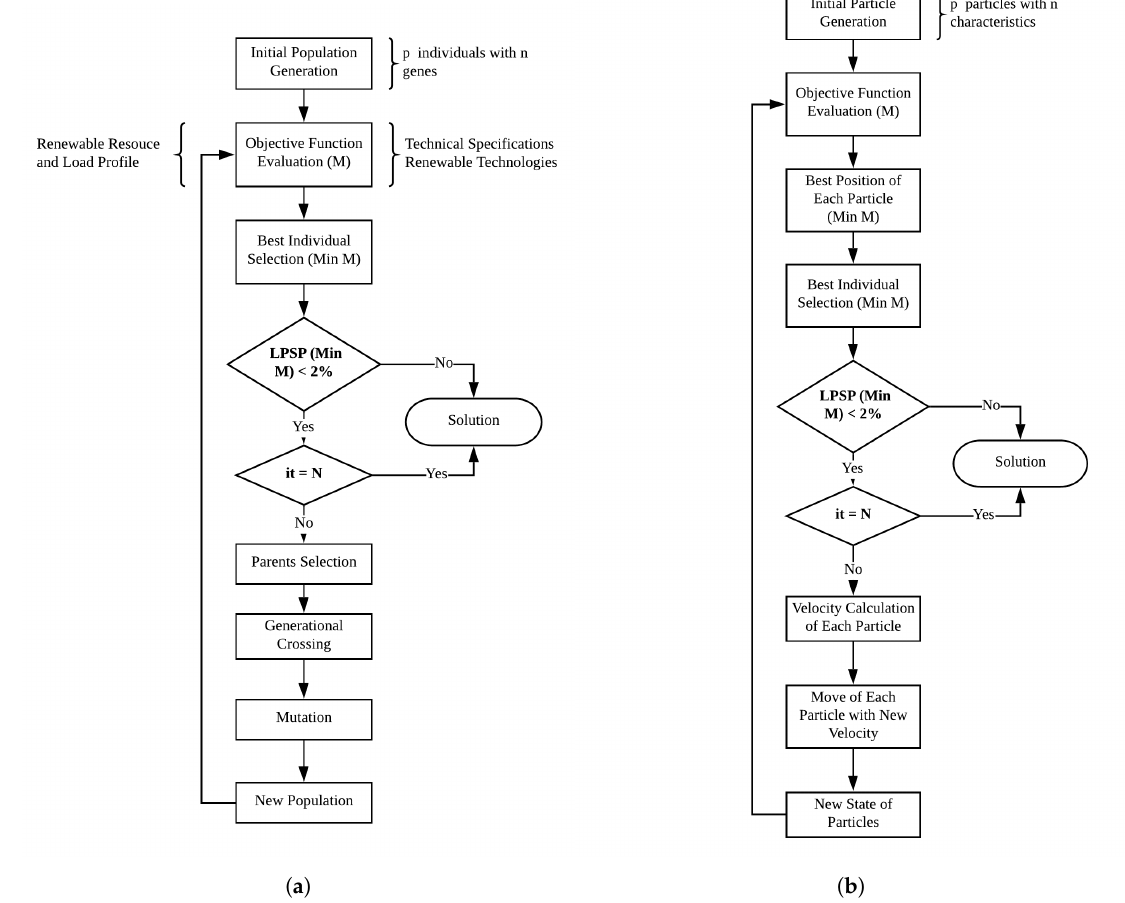
Figure 3. Sizing methods flow charts. ( a ) Genetic Algorithm GA. ( b ) Particle Swarm Optimization